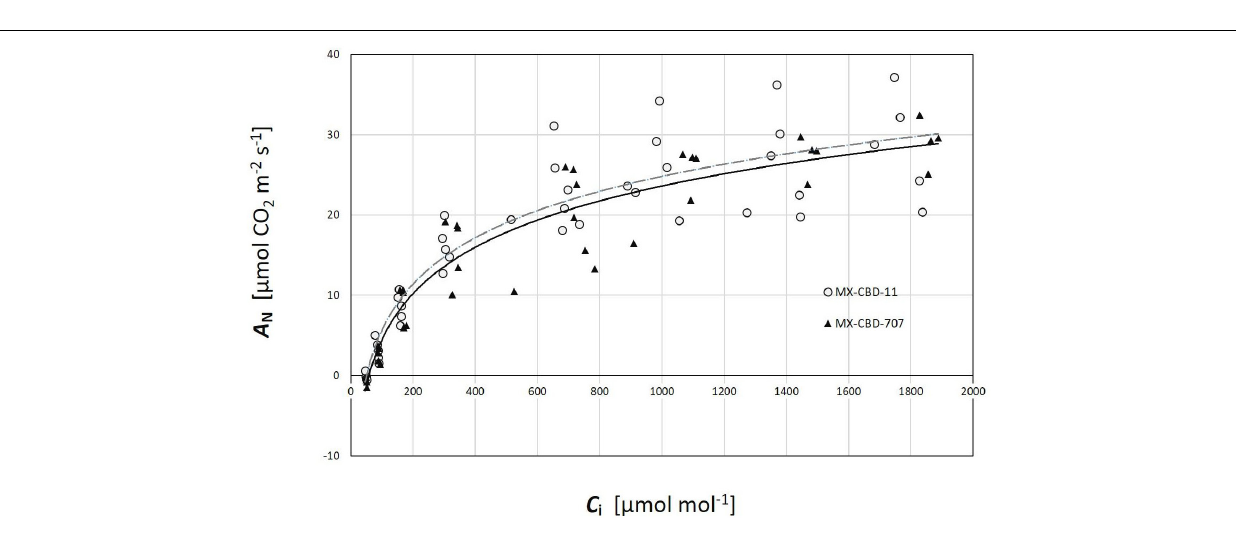
FIGURE 6 | Photosynthetic CO 2 response ( AC i ) curves of two breeding populations of medical cannabis MX-CBD-11 and MX-CBD-707. The data points indicate measurements on individual plants (5 plants of each